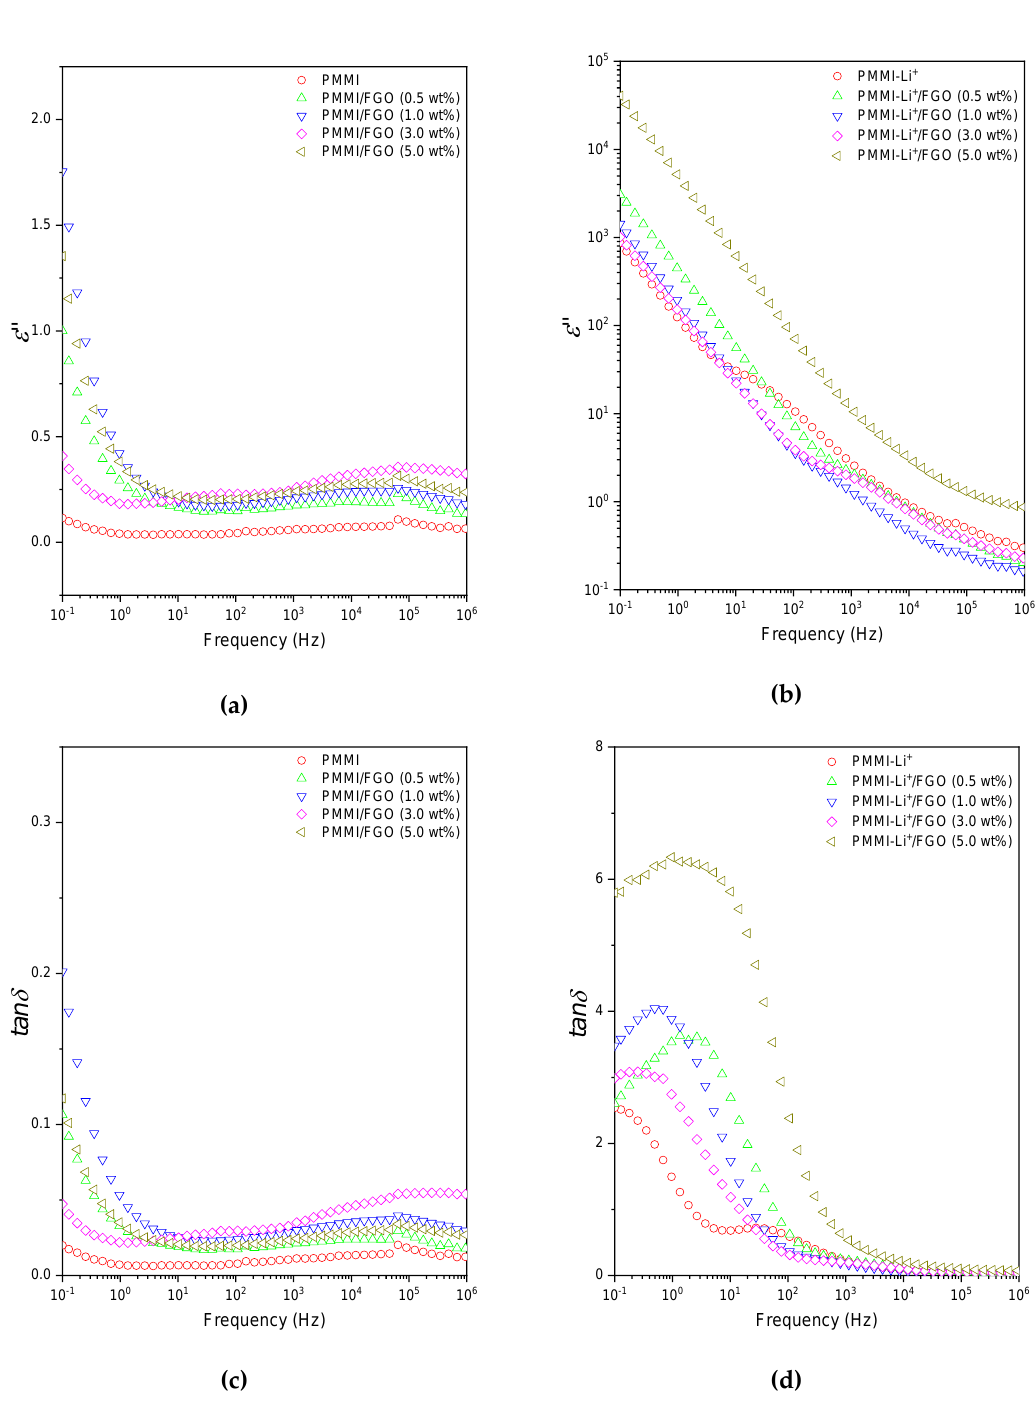
Figure 7. Dielectric loss factor as function of frequency for ( a ) PMMI/FGO and ( b ) PMMI-Li + /FGO nanocomposites; loss tangent ( tan δ ) as a function of frequency for ( c ) PMMI/FGO and ( d ) PMMI-Li + /FGO nanocomposites.